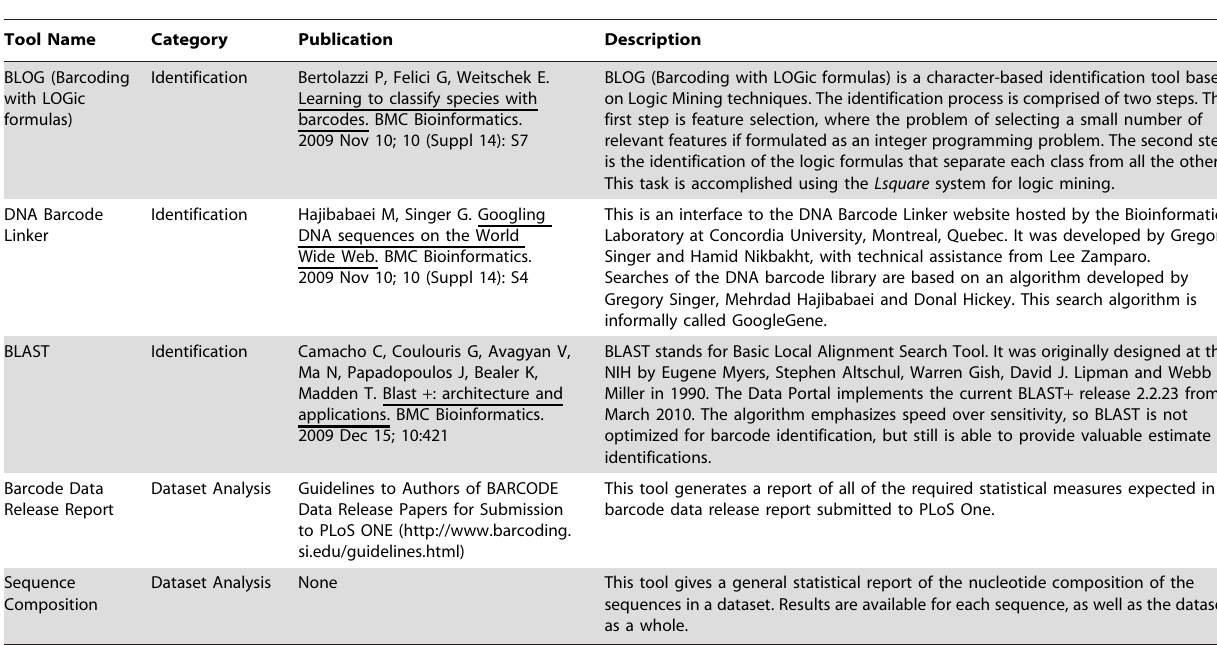
Table 1. List of current tools available in the